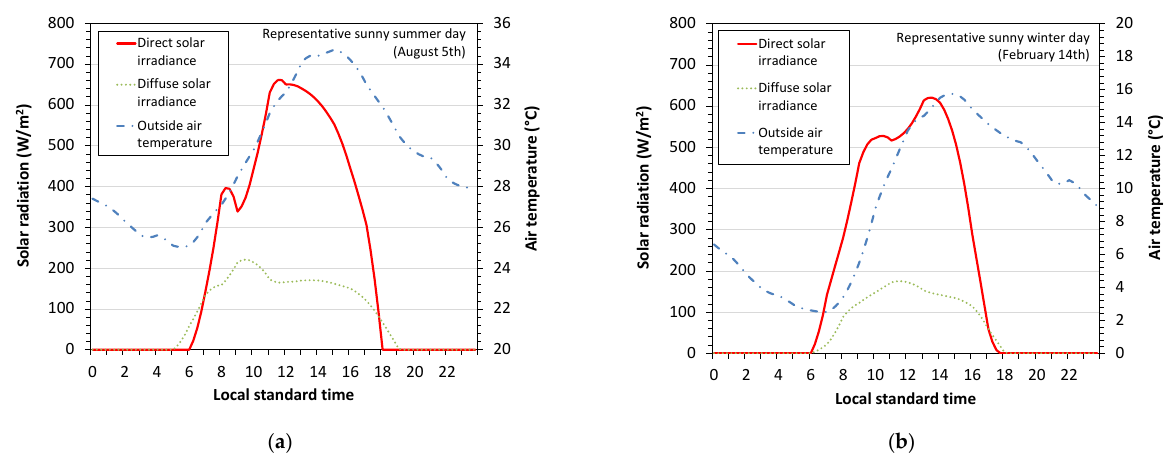
Figure 5. Weather conditions on a representative sunny day in ( a ) summer and ( b ) winter.